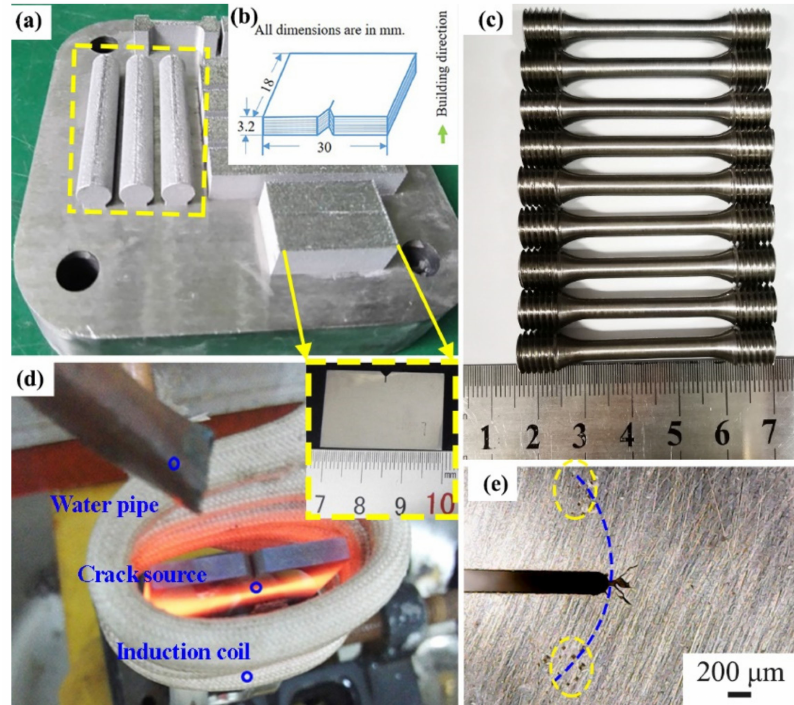
Figure 2. ( a ) SLM-processed bulk materials. ( b ) Profile of the specimen for TF tests. ( c ) Specimens for tensile tests. ( d ) Photo of the apparatus for TF test, adapted from ref. [9]. ( e ) Photo indicated the location where the hardness indents were